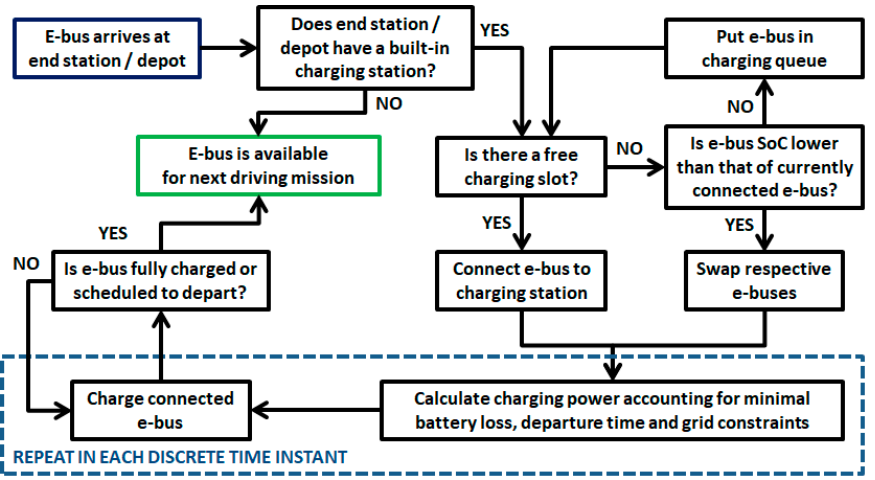
Figure 14. Flowchart of rule-based charging management algorithm (applied to PHEV- and BEV-type buses).